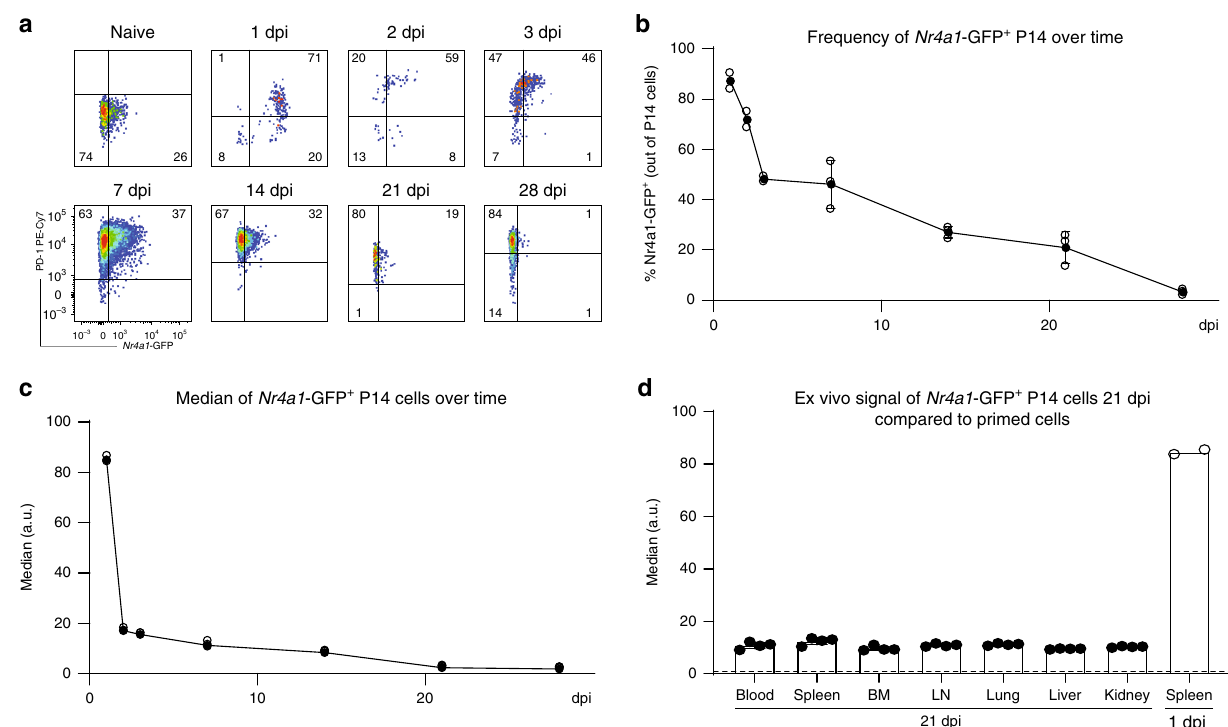
Fig. 2 In vivo kinetics of TCR activation during chronic infection. P14- Nr4a1 -GFP cells were adoptively transferred into mice 1 day prior high dose LCMV clone 13 infection. Animals were sacri fi ced at various time points. a Examples of fl ow cytometry plots showing expression of Nr4a1 -GFP and PD-1 in P14 cells (gated on alive single CD8 + CD45.1 + cells) isolated from the spleen of naive or chronically infected mice at various days post infection (dpi). Kinetics of GFP frequency b and GFP median c of P14- Nr4a1 GFP + cells. d Nr4a1 -GFP expression in P14 cells isolated from different tissues 21 dpi compared to the signal observed in activated cells isolated from the spleen 1 dpi. Full circles b , c and bar plots d represent mean ± SD. Empty circles b , c show individual data points. One of two experiments is shown ( n = 2 mice for 1 to 3 dpi and 3 mice for 7 to 28 dpi). Each dot represents an individual mouse. See also Supplementary Fig. 1. Source data are provided as a Source Data